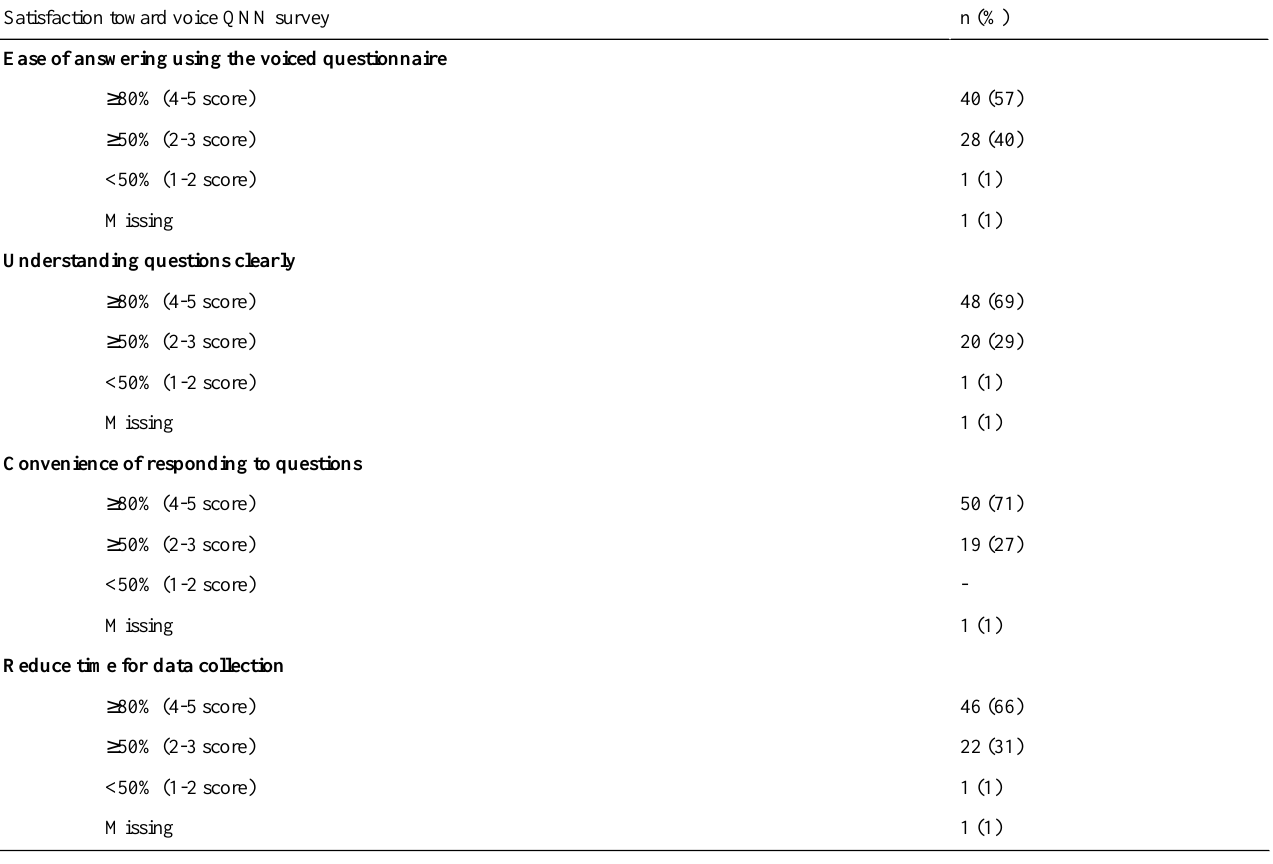
n (%)Satisfaction toward voice QNN